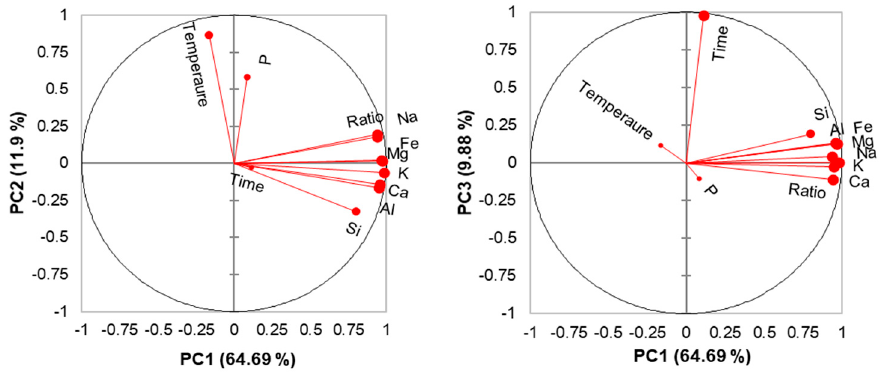
Figure 6. Principal component analysis (PCA) correlation charts.